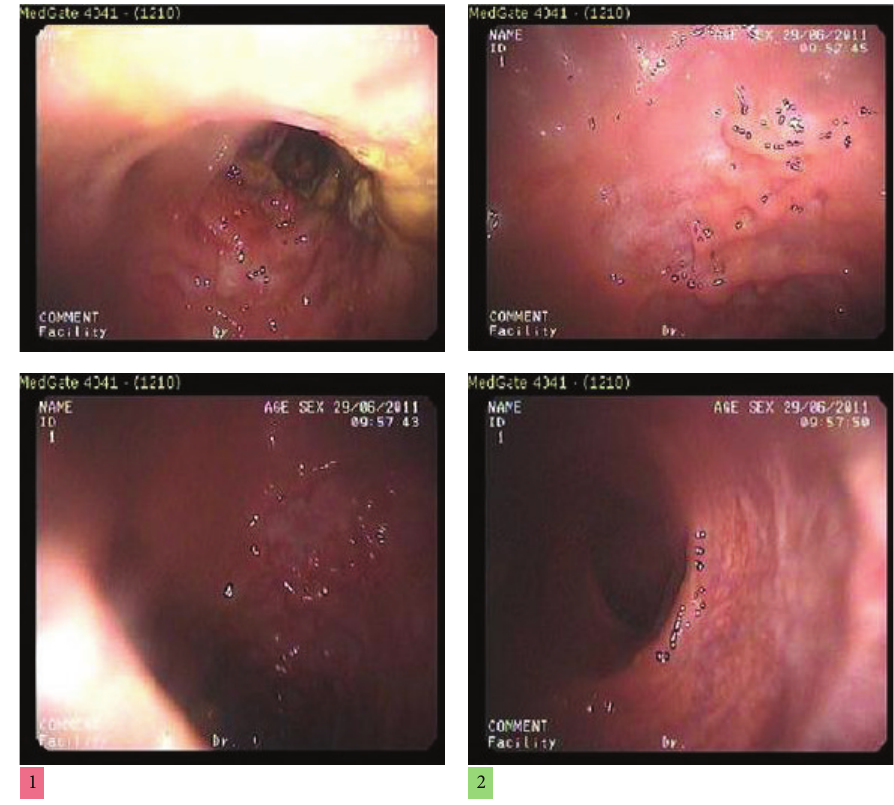
Figure 1: Colonoscopic